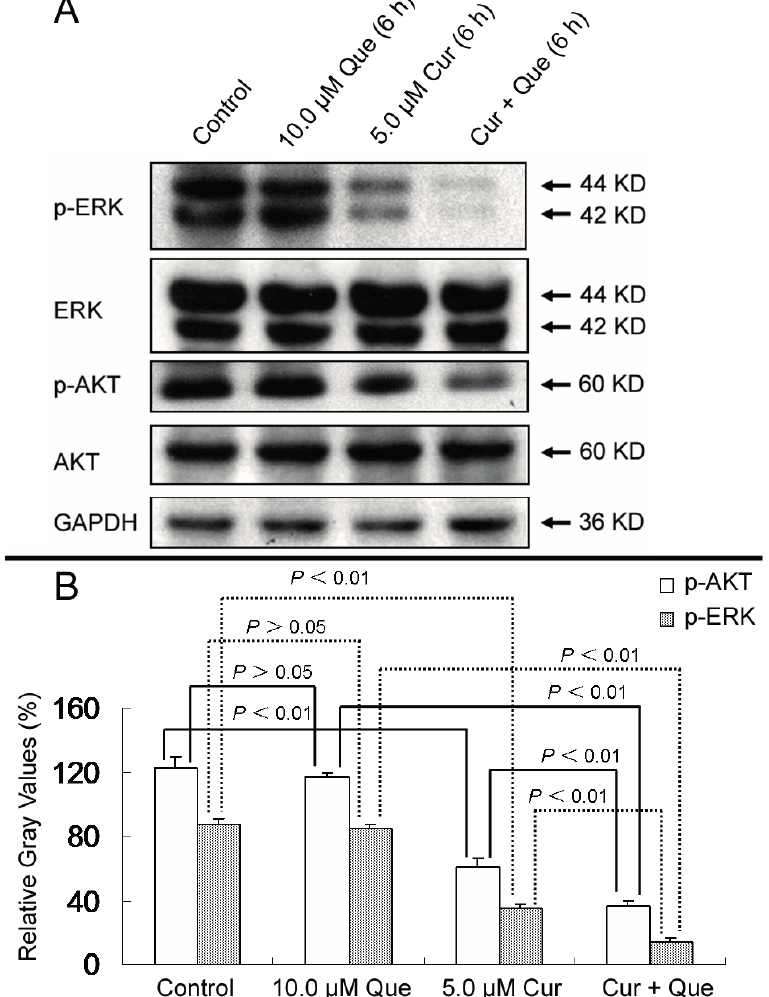
Figure 6. Effect of quercetin and curcumin on the expression of total and phosphorylation forms of AKT and ERK. MGC-803 cells were treated with quercetin (10.0 µM), curcumin (5.0 µM) or a combination of the two for 6 h; the protein expressions of p-ERK, ERK, p-AKT and AKT were then measured by western blot. ( A ) Expression of p-ERK, ERK, p-AKT and AKT in MGC-803 cells. ( B ) Gray intensity analysis of western blot results of p-AKT and p-ERK in (A). GAPDH (36 kDa) was used to ensure equal protein loading. Data are expressed as mean ± SD of at least three determinations. p < 0.05 and p < 0.01 represent a significant difference among